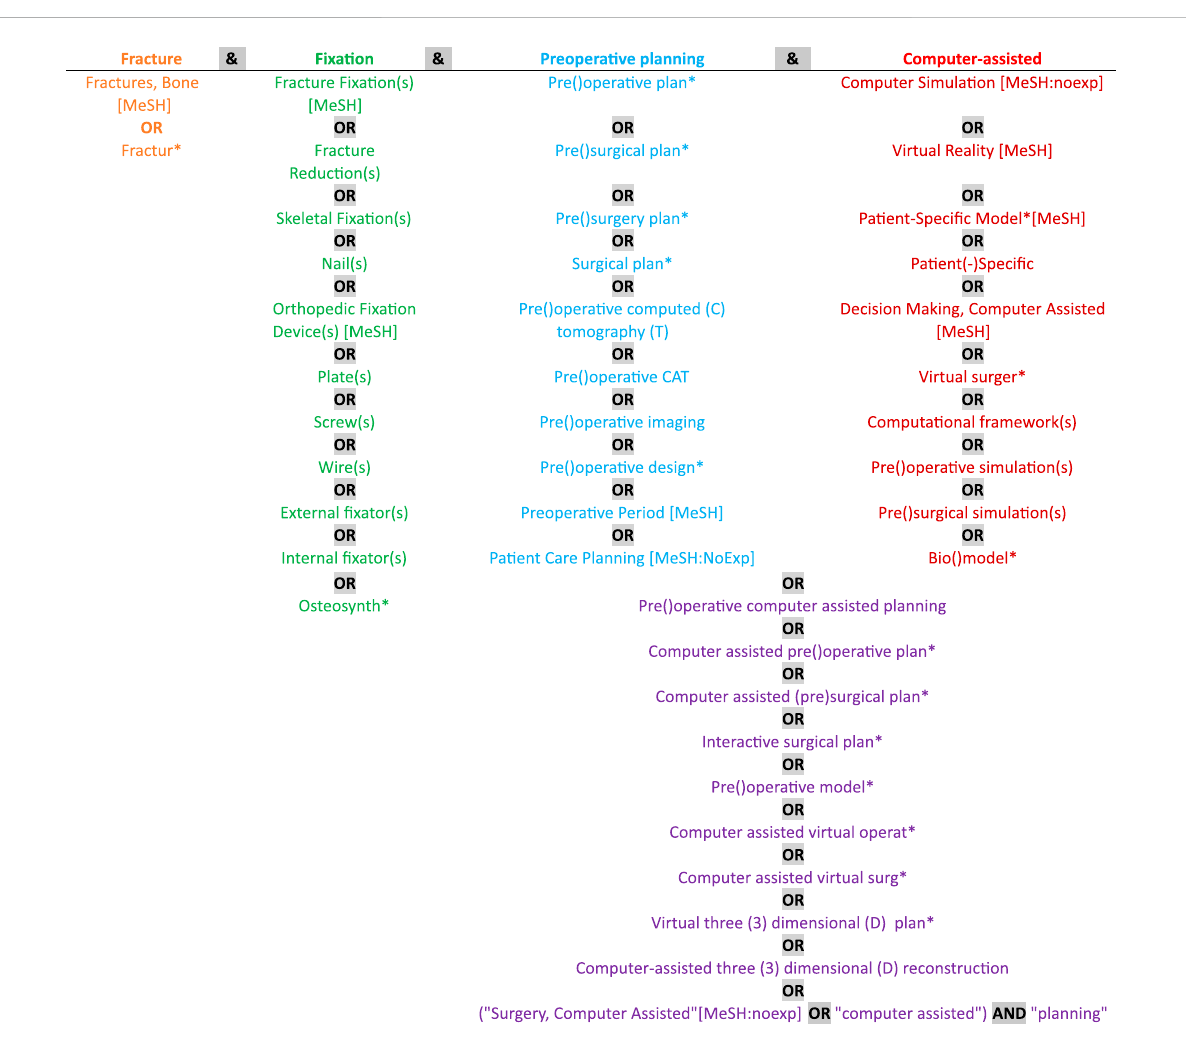
FIGURE 1 Schematic view of the query construction. Columns: aspects. Rows: